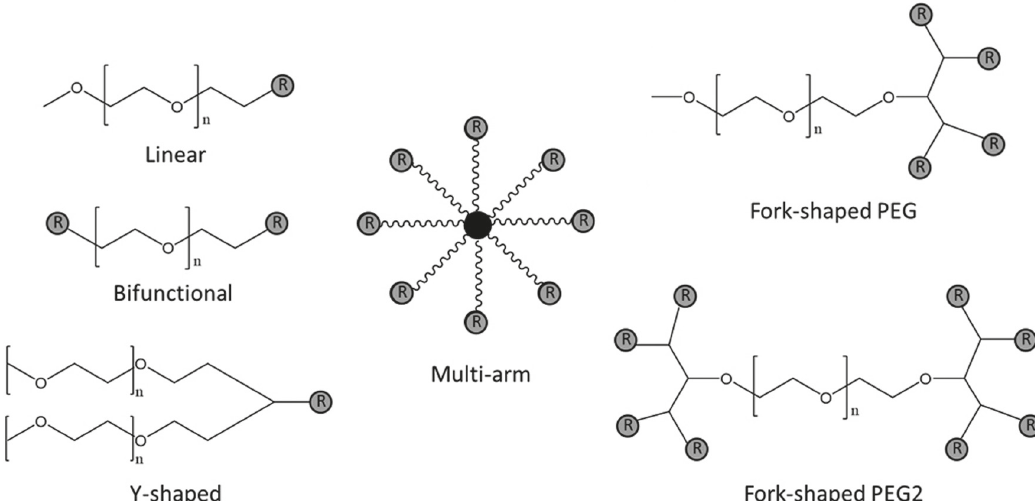
FIGURE 3 - Reactive PEGs used in PEGylation reactions. R represents functional groups of PEG derivatives. Linear - simplest and most often used conjugate agent with only one reactive group; Bifunctional – linear PEG derivative with two reactive groups; Y-shaped PEG - two linear PEG derivatives linked to a single point of attachment to proteins; Fork-shaped PEG - multi-proximal reactive groups at the end of one or both ends of a linear PEG chain; Multi-arm PEG – an eight-arm PEG carrying multi-hydroxyl or other functional groups (R) with pentaerythritol, hexaglycerol, or tripentaerythritol as the central